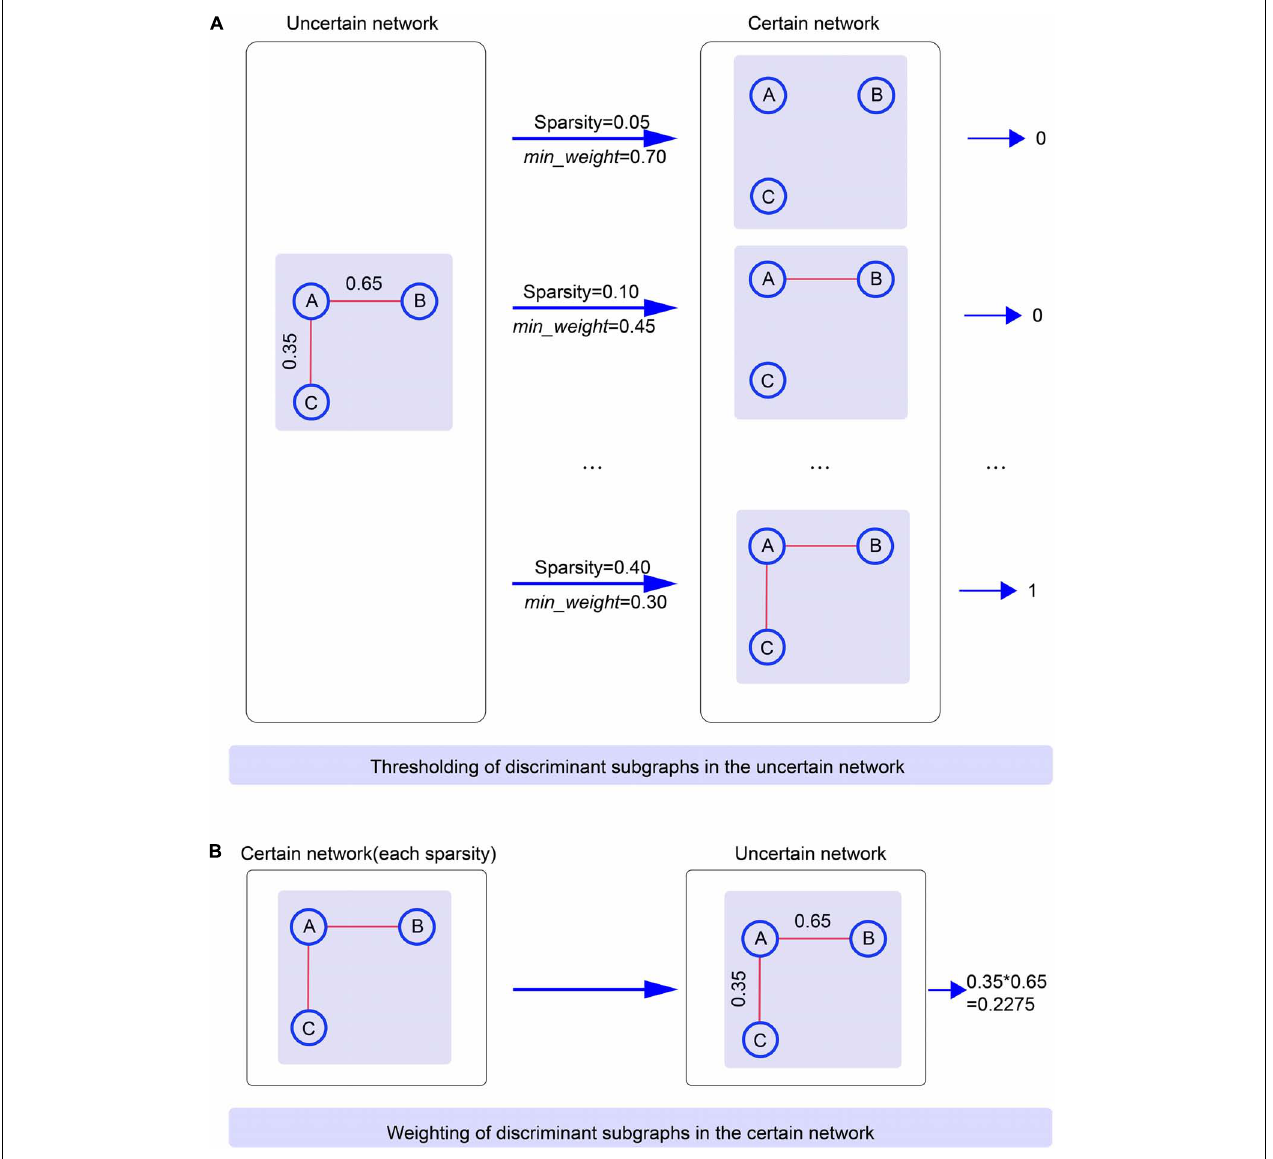
FIGURE 5 | The process of thresholding and weighting between uncertain networks and certain brain networks. Specific clarification is that (A) Illustrates the thresholding of discriminant subgraphs in the uncertain network. (B) Illustrates the weighting of discriminant subgraphs in the certain